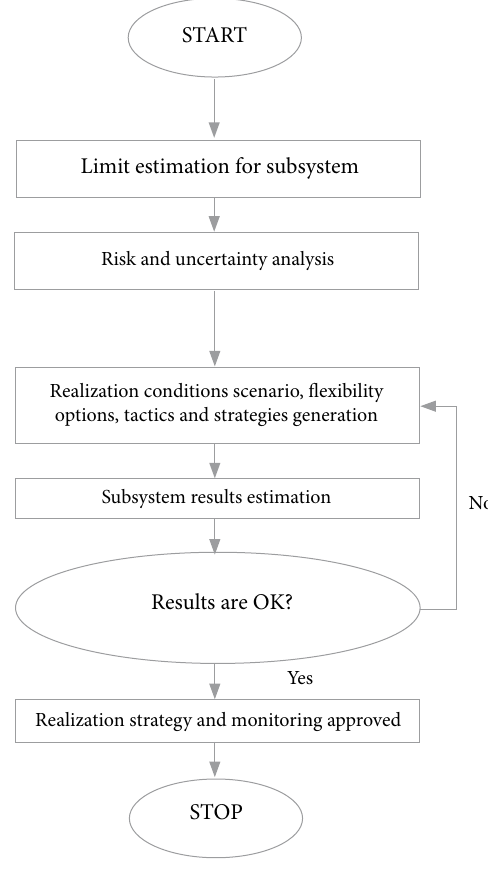
Fig. 1. Flexibility management method idea in planning